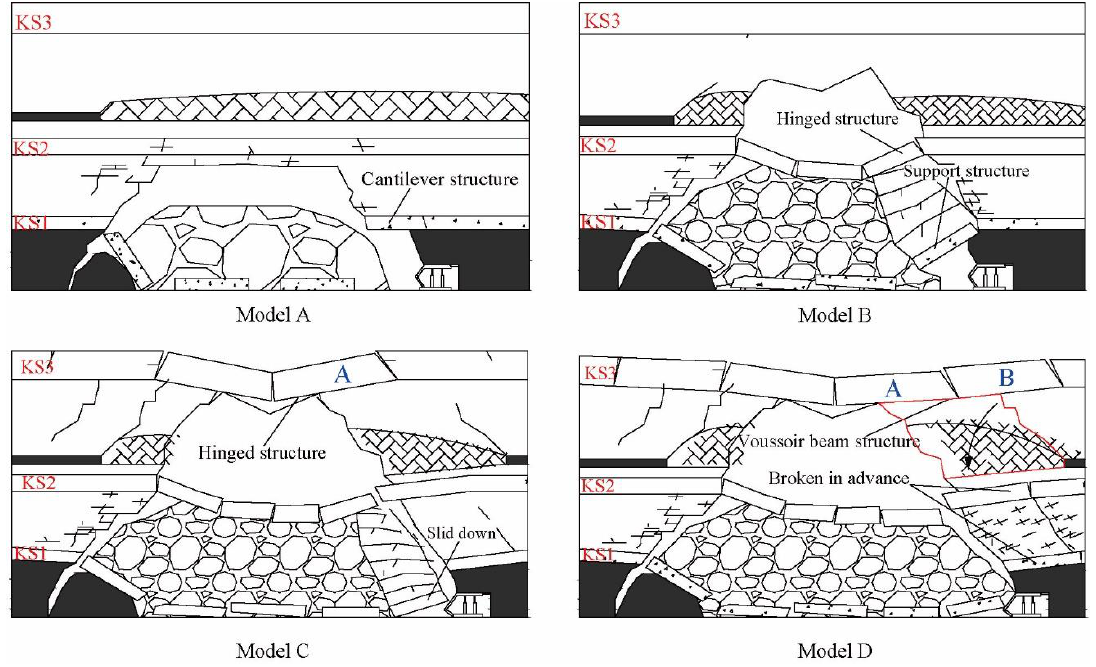
Figure 6. Structural models of the overlying strata on the LTCC panel. (Blue part A and B refer to the two key blocks in voussoir beam structure of the key roof strata.).